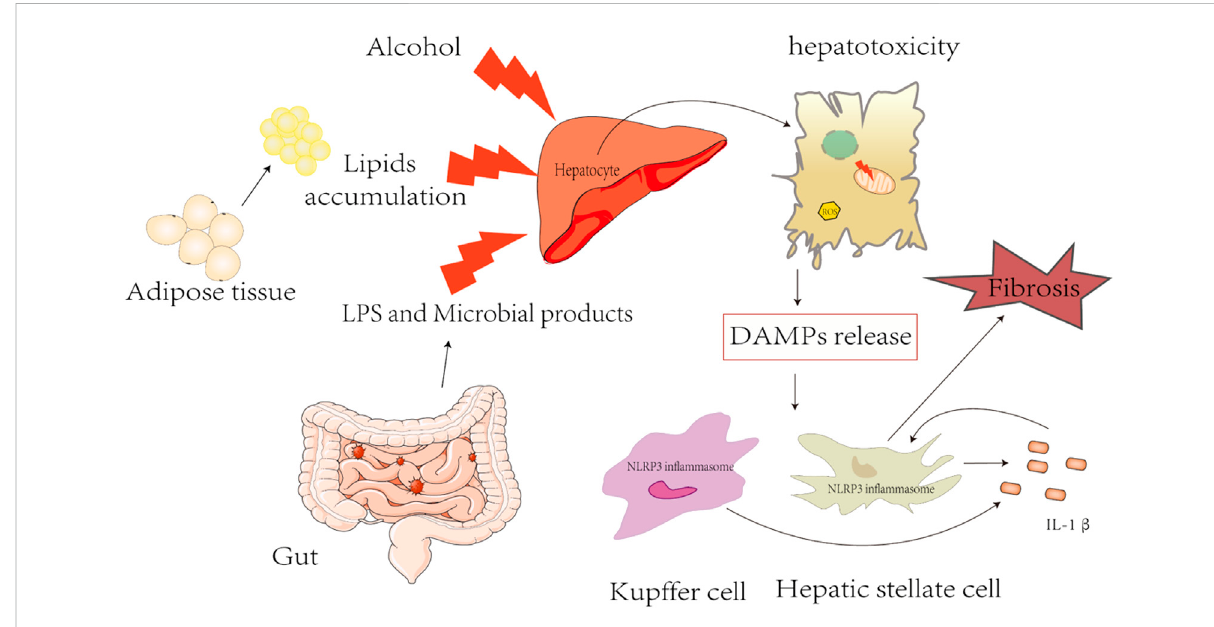
FIGURE 2 Triggers of in fl ammasome activation in fatty liver